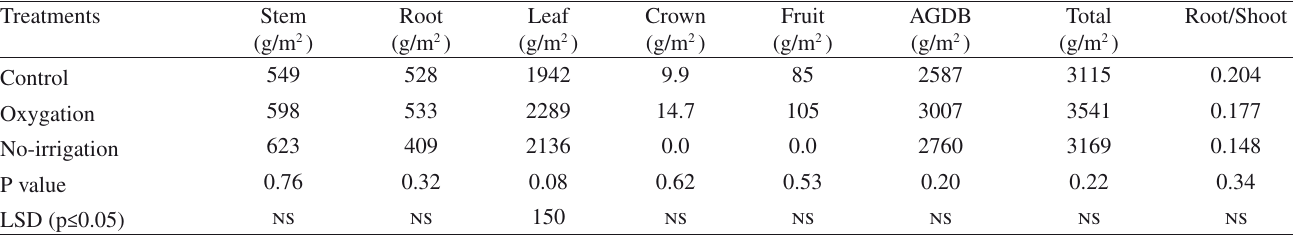
Table 5 - Effect of oxygation on dry plant weight and its components at harvest of the ratoon crop (713 DAT)